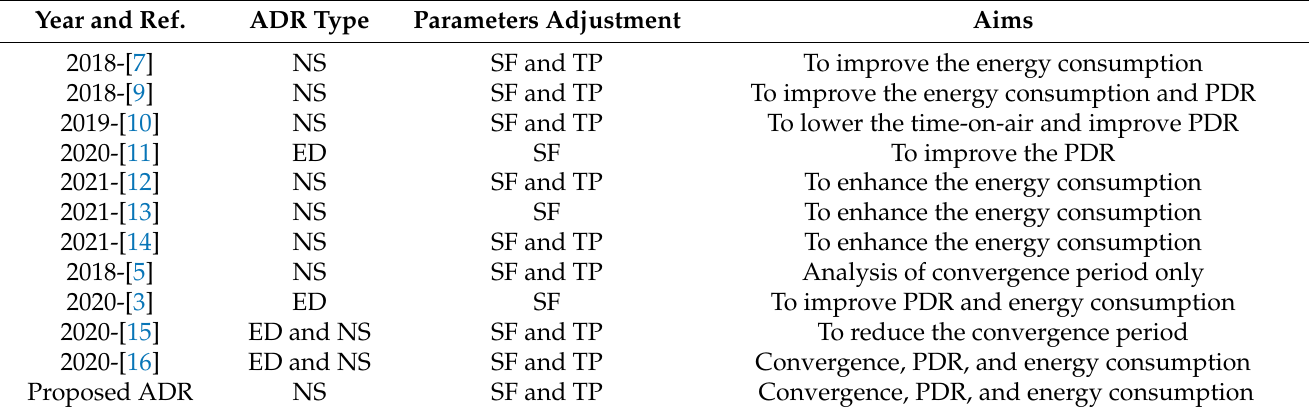
Table 2. Summary of existing